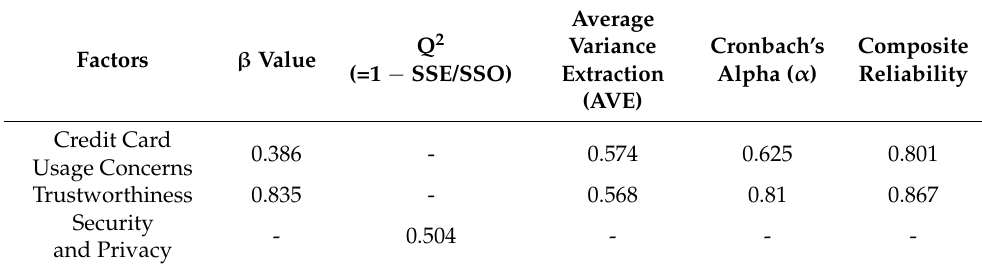
Table 8. Predictive relevance of model factors for SHEIN.